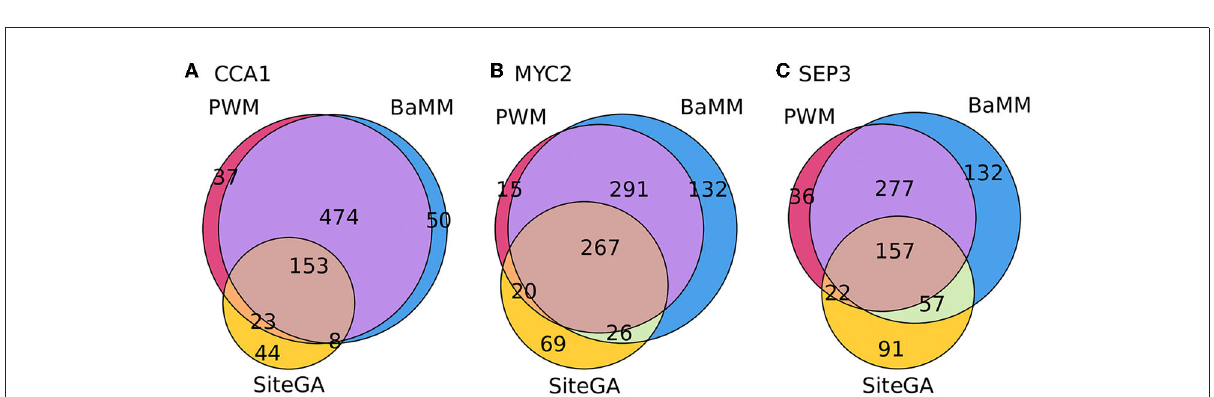
FIGURE5 Venn diagrams for overlaps between the fractions of peaks containing the BSs predicted by three different models. (A–C) Show CCA1, MYC2, and SEP3 datasets, respectively. Numbers denote the number of peaks. Totally, each dataset consists of 1,000 peaks. The analysis was performed with the medium thresholds (recognition scores respecting ERR 6